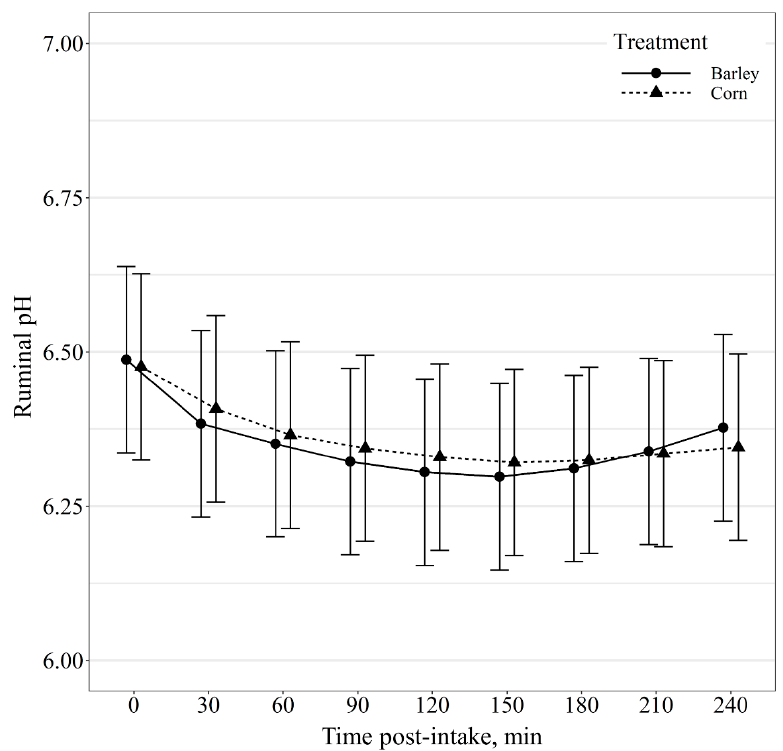
Figure 6. Ruminal pH change as a function of time (min) relative to intake event of beef steers provided barley- or corn-based feedlot diets. Ruminal pH was influenced by a diet × minute post-intake event interaction ( p < 0.01); however, no differences ( p ≥ 0.63) were observed between diets within post-intake event time periods.